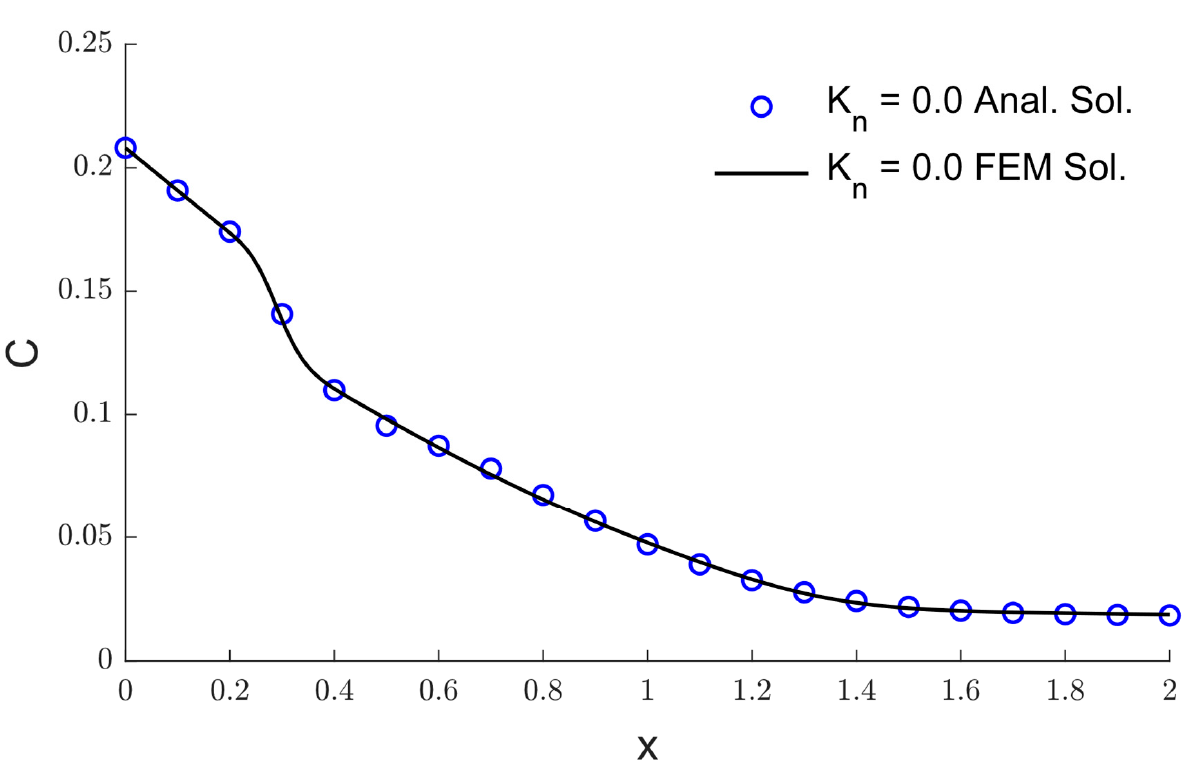
Figure 12. The displacement comparison study when τ o = τ 1 = 0.05 and K n = 0.